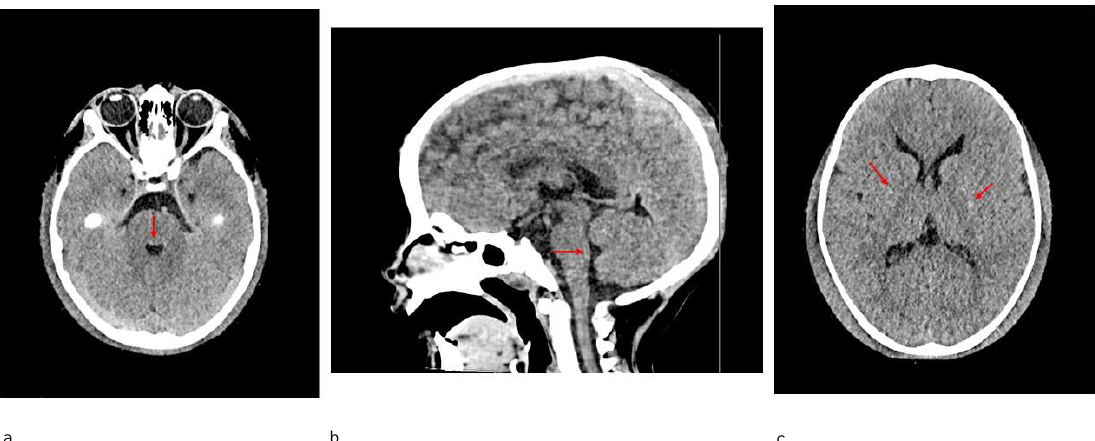
Figure 4. CT scan of the brain of patient 2 showing ( a , b ) dysmorphism of the pons with bulging of the dorsal surface (arrows), ( c ) small areas of mineralization at the level of lenticular nuclei (arrows); pericranial soft tissue swelling and edema surrounding cranial bone are also evident in all 3 images.